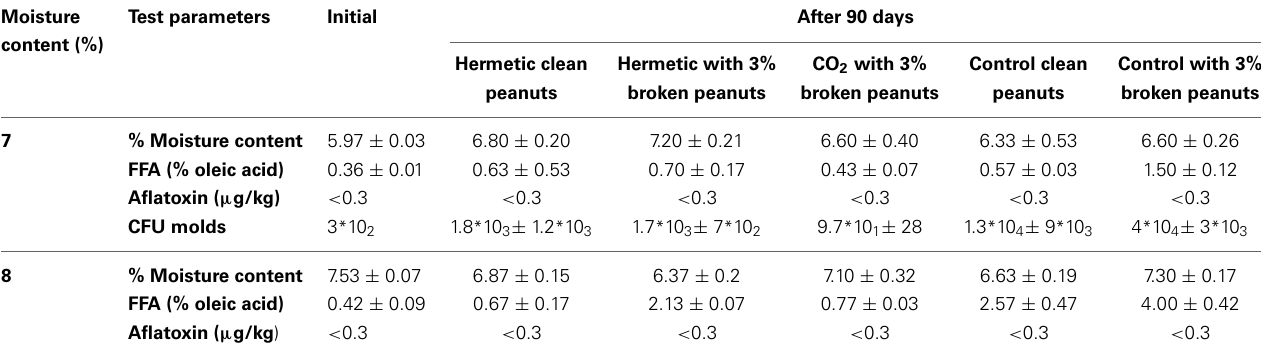
Table 2 | FFA and CFU mold levels in